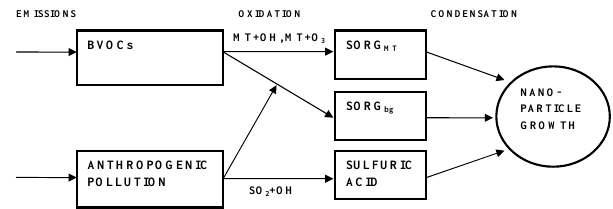
Fig. 1. Schematic of processes leading to nanoparticle growth from the perspective of the parameterization: formation of SORG MT , SORG bg and sulfuric acid from biogenic volatile organic com- pounds (BVOCs) and anthropogenic pollution via atmospheric oxi- dation and condensation of these vapors onto nanoparticles. Model simulations with GEOS-Chem-TOMAS (Pierce et al., 2013) show that SORG bg can be linked to the products of oxidation of biogenic organics in the presence of anthropogenic pollutants (Hoyle et al., 2011; Spracklen et al.,